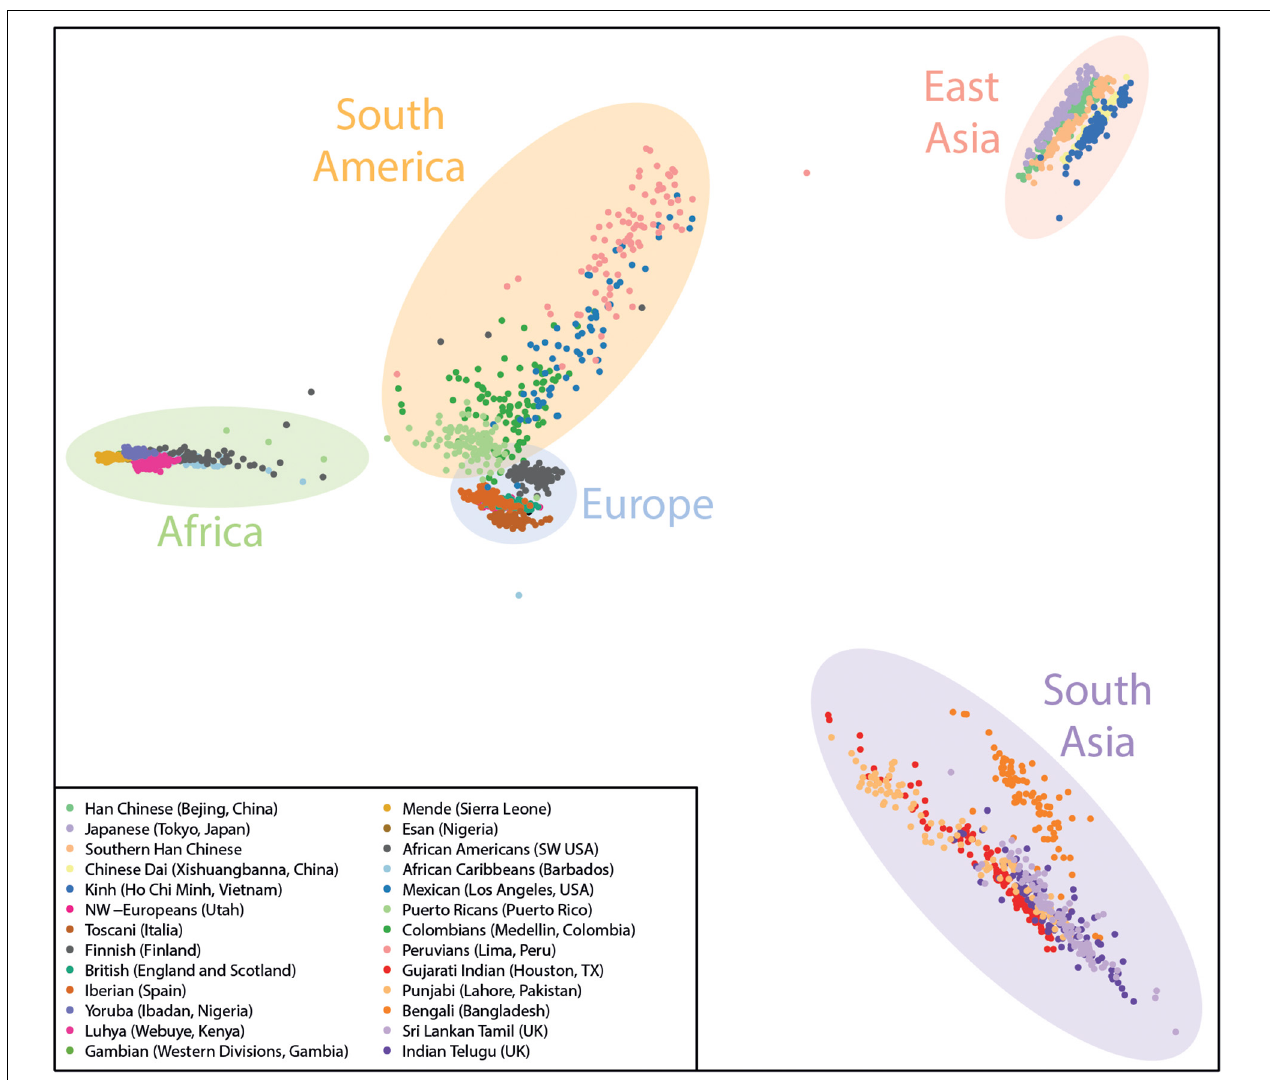
FIGURE 2 | Example Ancestry PCA plot containing the current reference data from the 1000 genomes project used by GenomeChronicler, with shaded areas broadly illustrating the origin of the populations